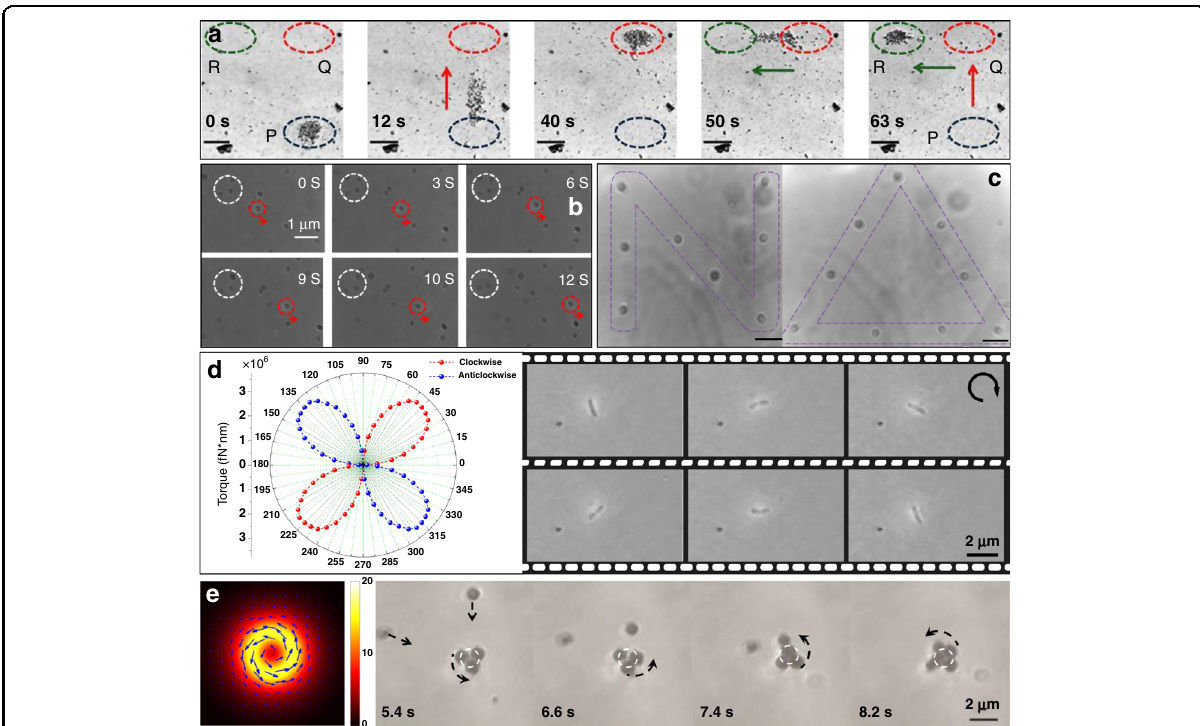
Fig. 10 Plasmonic manipulation of micro- and nanoobjects on a smooth metallic surface. a Plasmonic manipulation and transport of a nanoparticle assembly on a smooth metallic surface, from initially trapped area P to fi nal area R via point Q. Reproduced with permission from ref. 147